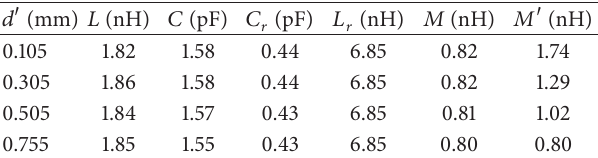
Table 1: Extracted circuit parameters for different values of 𝑑 󸀠